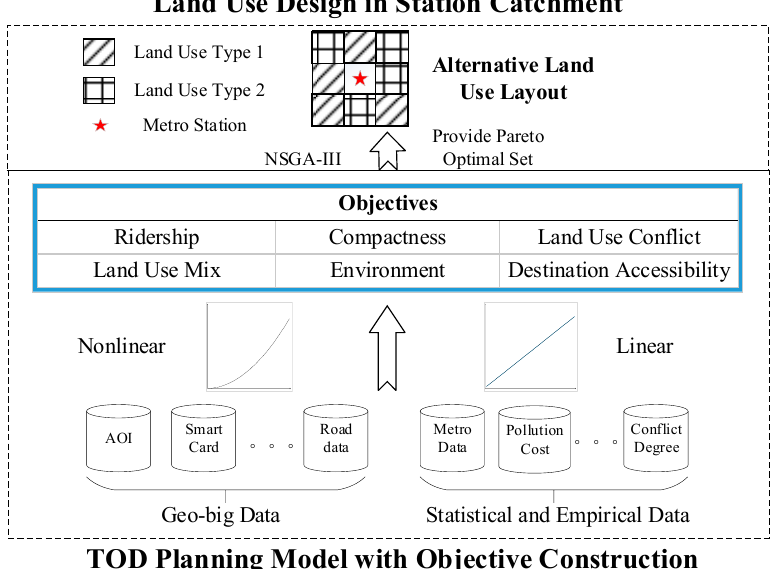
Figure 2. Work flowchart of the TOD land use design framework.